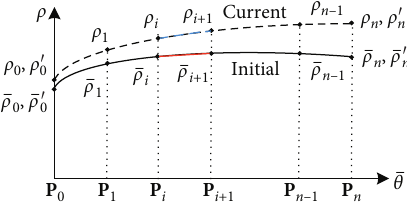
Figure 3: Configuration curve of the variable helix radius in the initial state and current state.